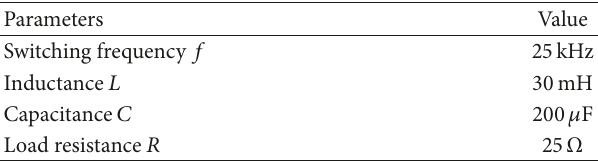
Table 4: Operating values for the boost